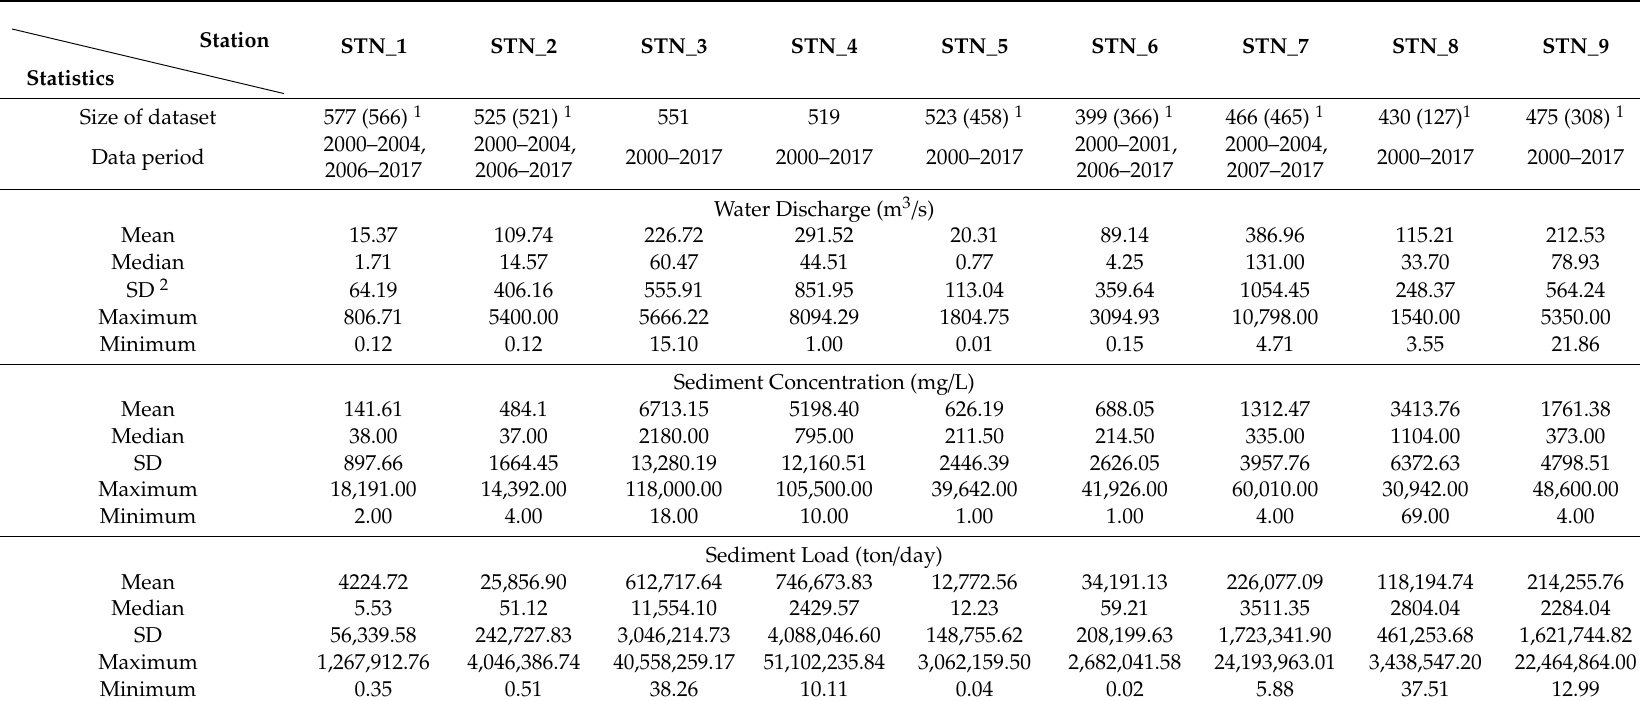
Table 3. Descriptive statistics of corresponding data on water discharge and sediment for the five watersheds during